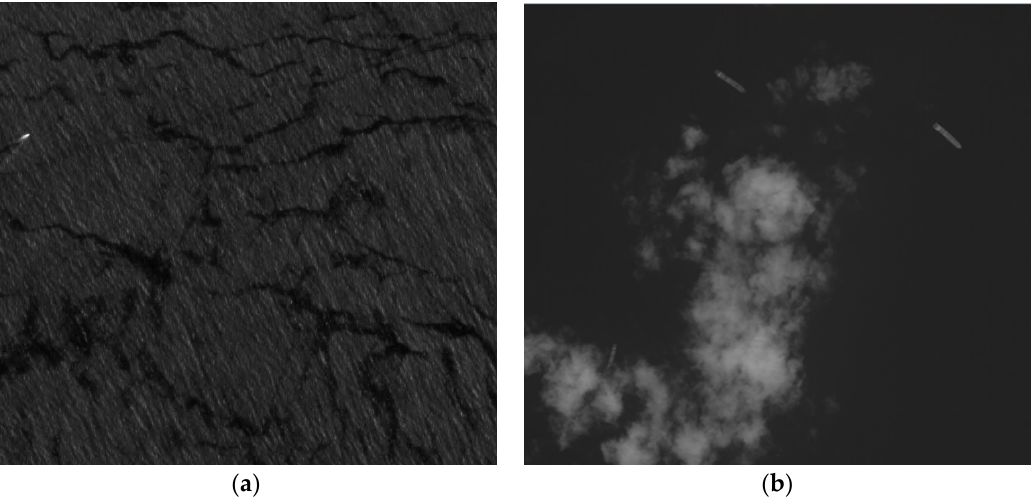
Figure 7. The original images to be tested. ( a ) Strong waves; ( b ) cloud coverage.